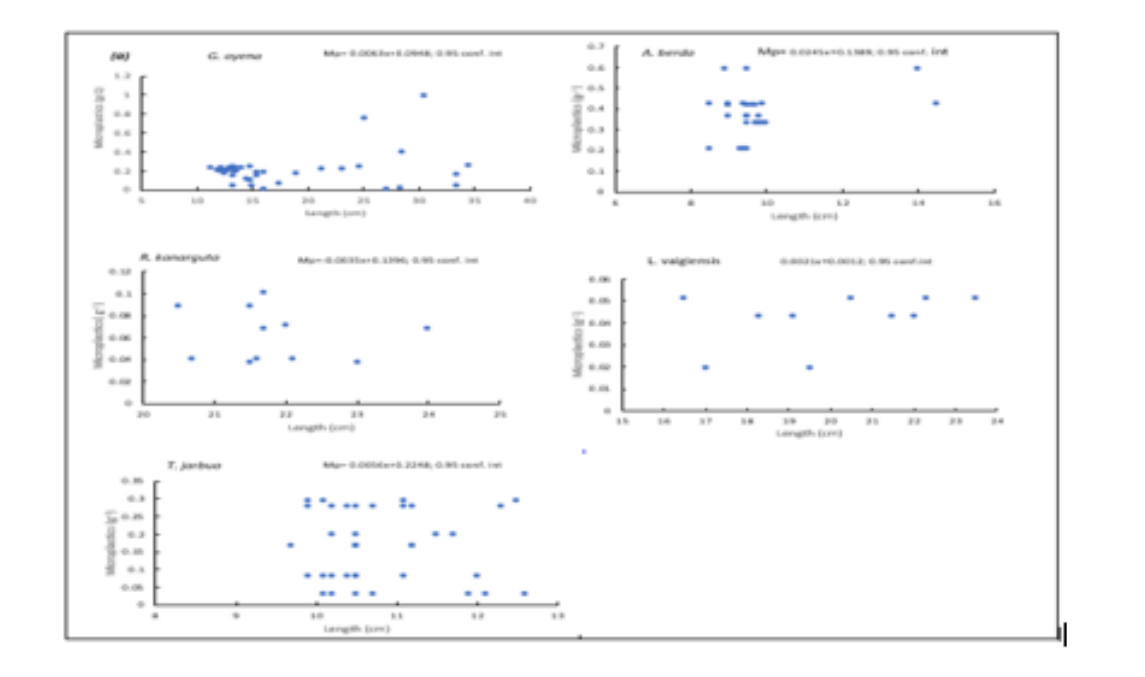
Figure 4: Relationship between (a) MPs concentration and body length and (b) MPs concentration and body weight in the different